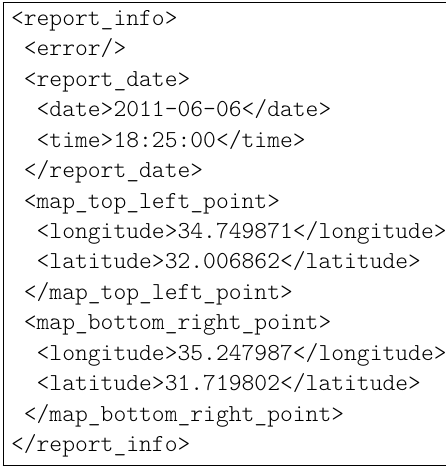
Figure 4. A possible example of XML-formatted document created by the Application Server